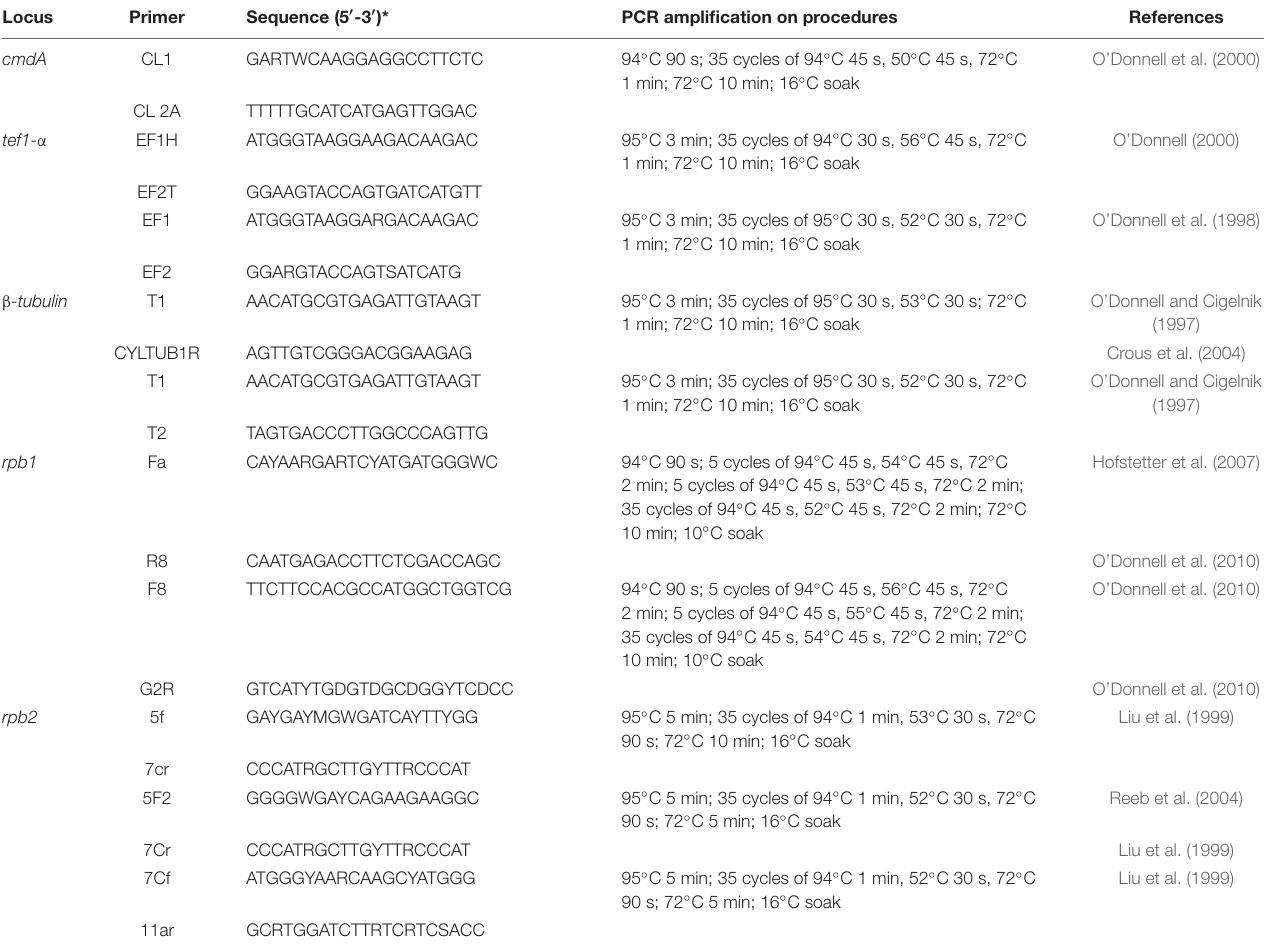
TABLE 1 | Gene regions and respective primer pairs used in the study. Locus Primer Sequence (5 (cid:48) -3 (cid:48)